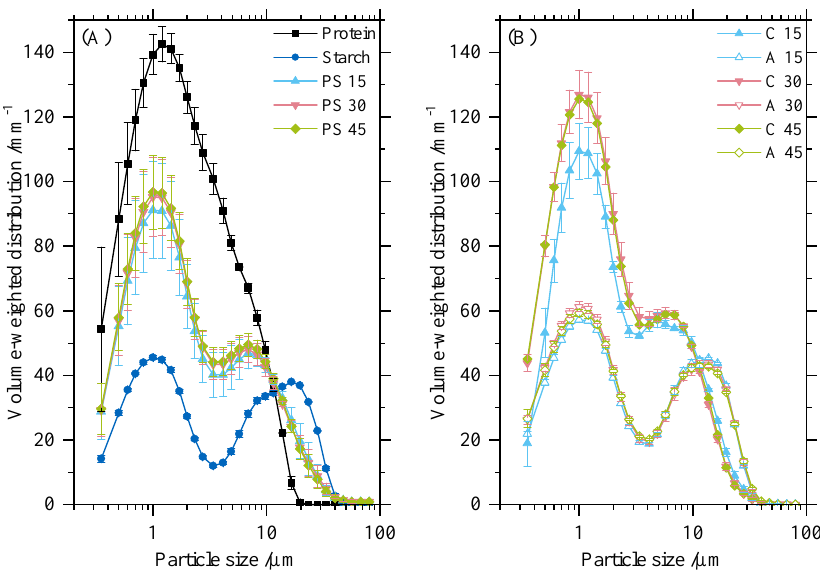
Figure 2. Particle size distributions of native powders, powder mixtures ( A ) and powders collected after separation ( B ) on cathode C (closed symbol) and anode A (open symbol). PVC was used as wall material in the charging tube. Despite varying protein content, initial powder mixtures have no different particle size distributions. On the cathode, an initially higher protein content results in finer powder. No such difference is visible on the